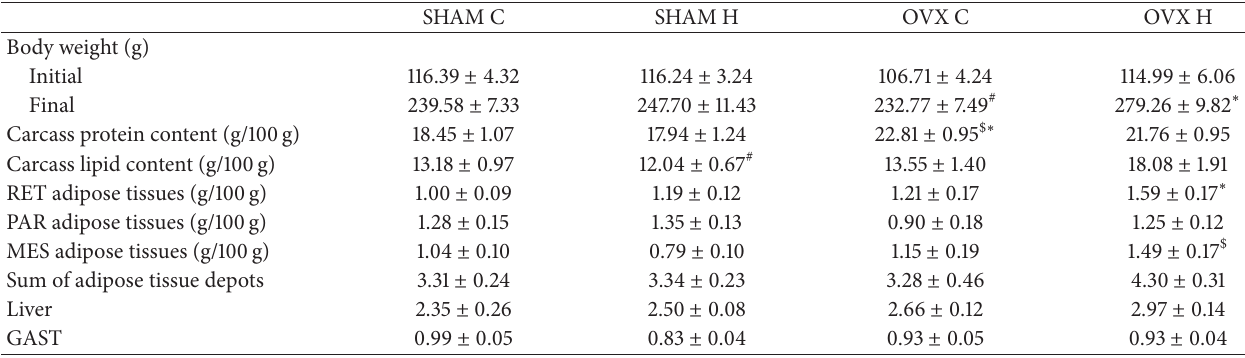
Table 2: Body weight, tissue weight, sum of adipose tissue depots, carcass protein, and lipid content of studied rats groups. SHAM C SHAM H OVX C OVX H Body weight (g)